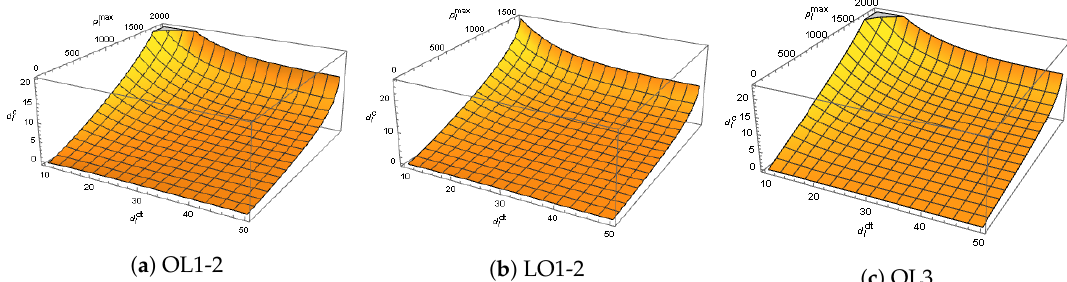
Figure A1. Approximated relations between canister spacing, tunnel spacing, and canister